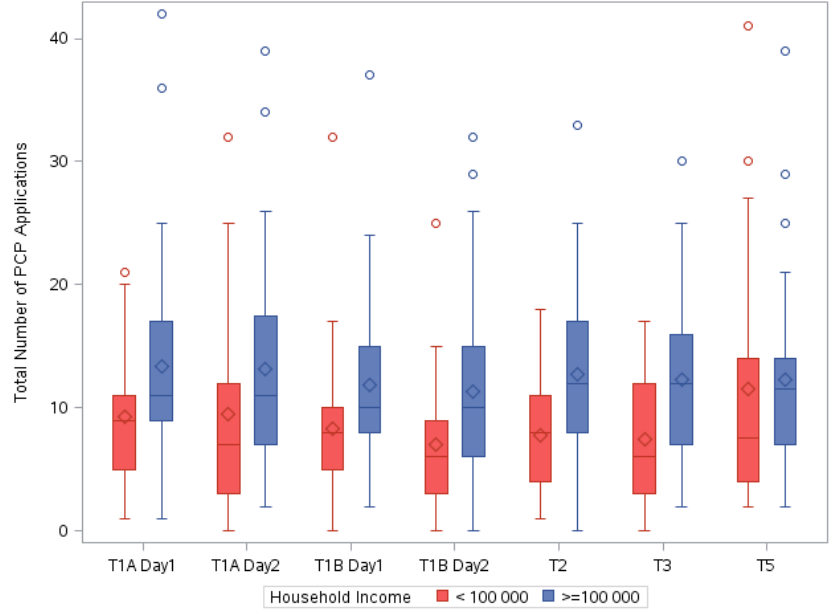
Figure 2. The total number of PCP applications within a 24 h period and household income group. The diamond inside the box indicates the mean value and the line inside the box indicates the median value. The bottom and top edges of the box indicate the 25th and 75th percentiles. The vertical lines represent the range of values with outliers indicated by circles.